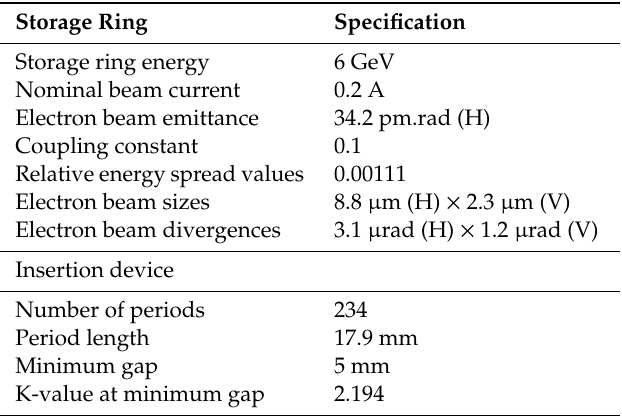
Table 3. Basic simulation parameters of 6 GeV storage ring and typical undulator in beamline for the high energy photon source (HEPS).